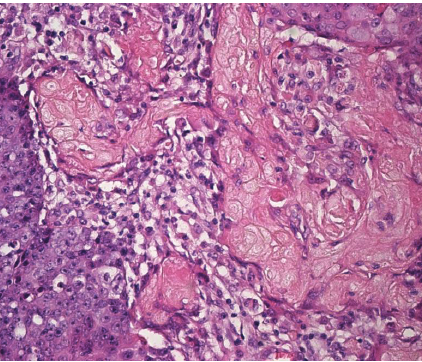
Figure 1: At low-power, dark basaloid cell clusters in desmoplastic stroma and necroses are seen (hematoxylin and eosin).